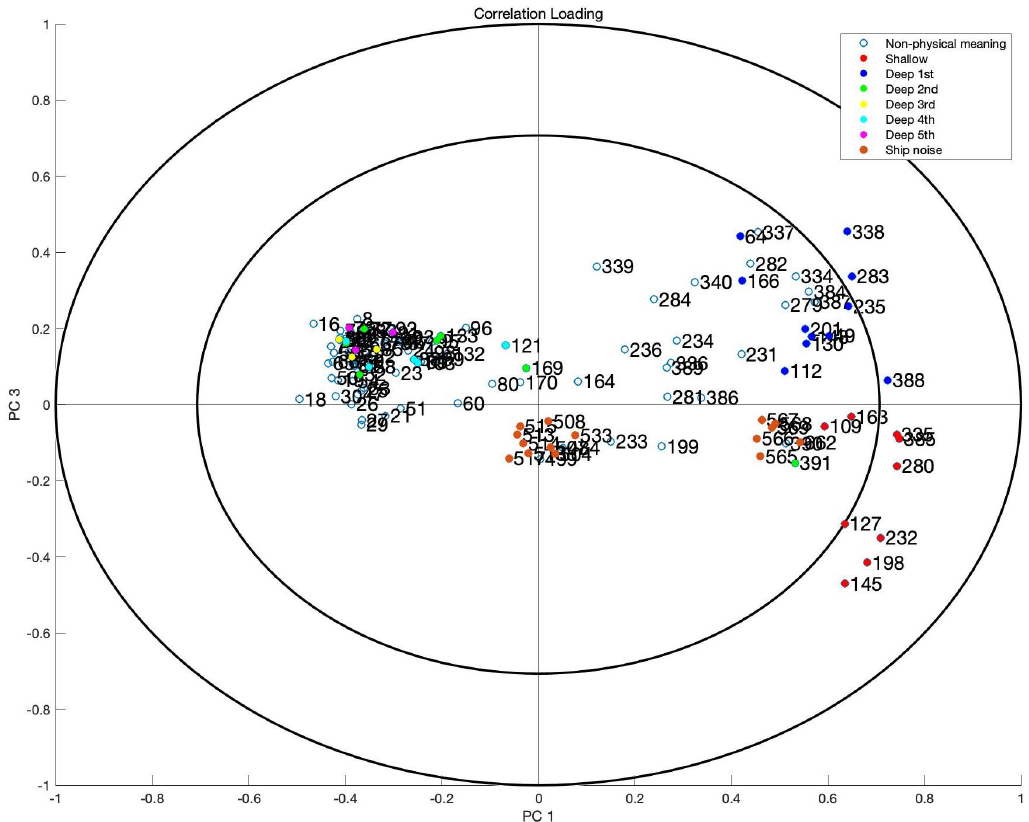
Figure 5. Correlation loading